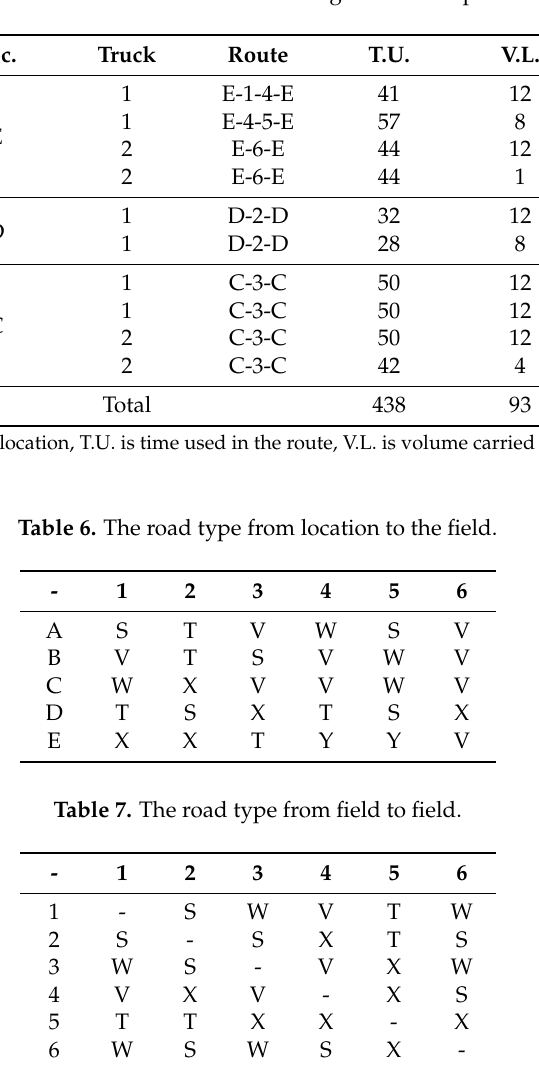
Table 5. The result of the routing of the example.